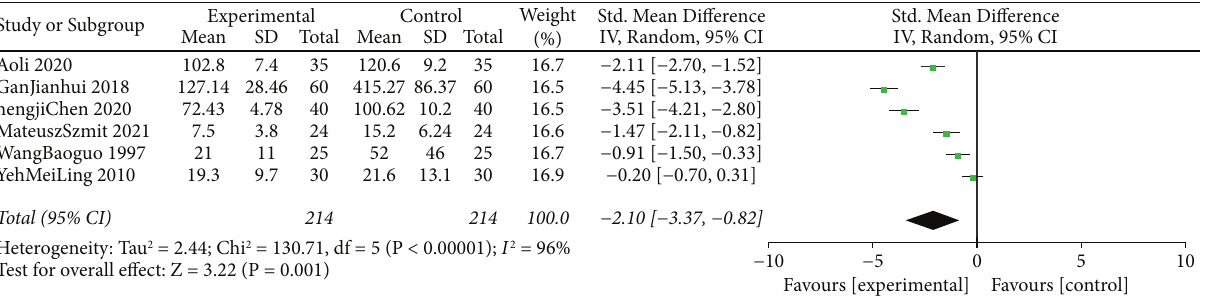
Figure 7: Forest plots comparing the incidence of postoperative analgesic consumption between the TEAS and control groups.